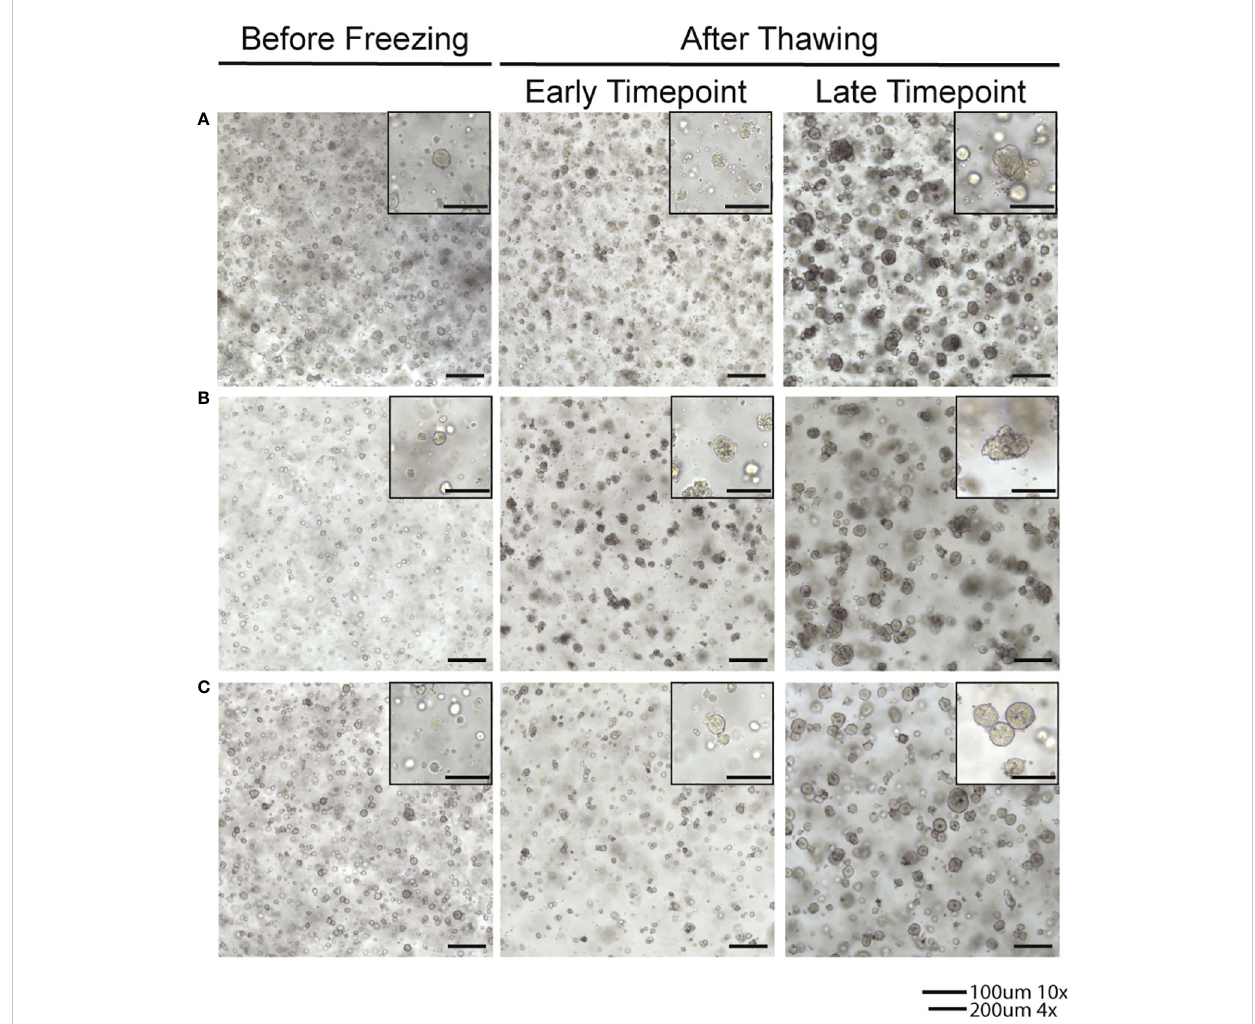
FIGURE 2 Bright fi eld images of organoids in culture after thawing from frozen samples. (A) Line frozen after 8 passages established in culture. (B) Line frozen after 9 passages established in culture. (C) Line frozen after 10 passages established in